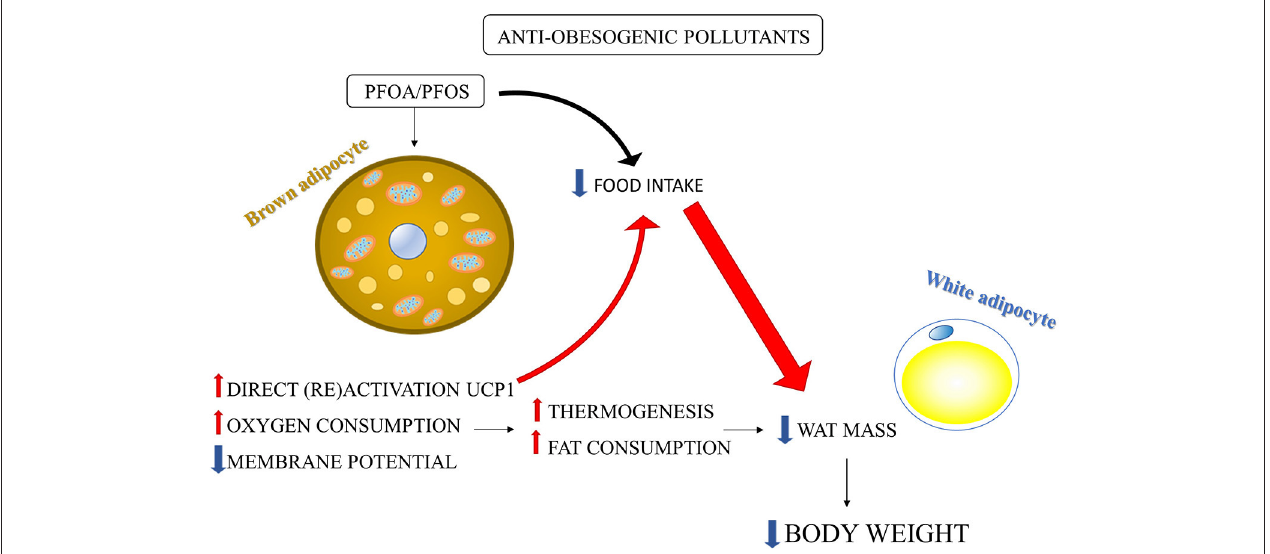
FIGURE 2 | Environmental pollutants-induced body weight reduction: involvement of BAT activation. PFOS and PFOA induced in isolated brown-fat mitochondria: (1) direct (re) activation of UCP1; (2) mitochondrial membrane potential dissipation; (3) mitochondrial oxygen consumption increase. The consequent increase in fat combustion and energy expenditure may induce reduction in WAT mass and body weight. However, PFOS/PFOA-induced body weight reduction was mainly due to a reduction in food intake rather to the increase in thermogenesis. The large part of the PFOS/PFOS-induced food intake reduction was dependent on the presence of UCP1 in BAT (Shabalina et al., 2015,